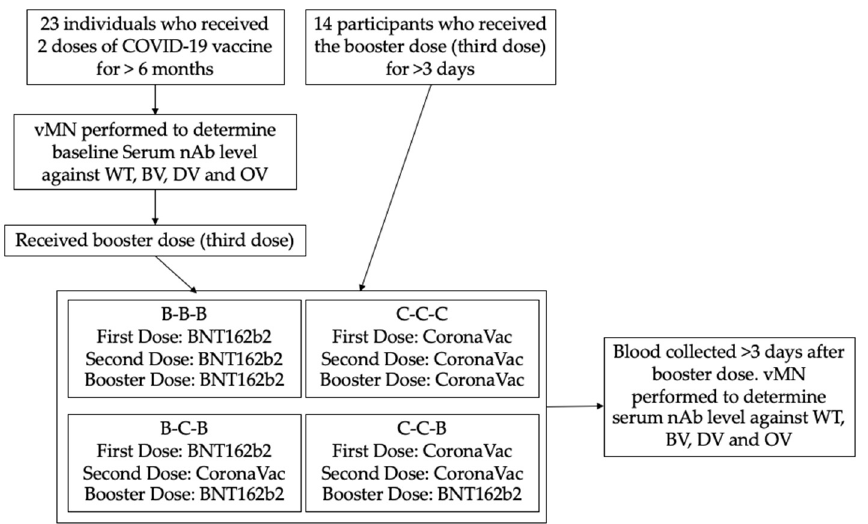
Figure 1. Procedure of the study. vMN: virus microneutralization assay; nAb: neutralizing antibody; WT: SARS-CoV-2 wild type; BV: SARS-CoV-2 Beta variant; DV: SARS-CoV-2 Delta variant; OV: SARS- CoV-2 Omicron